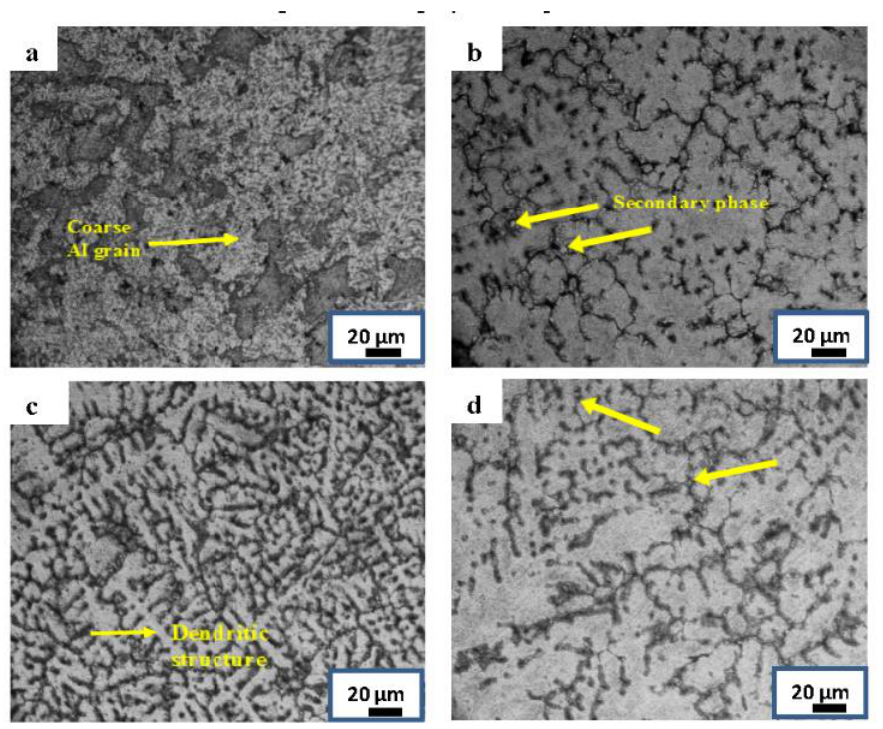
Fig. 2. Optical micrographs of the transverse